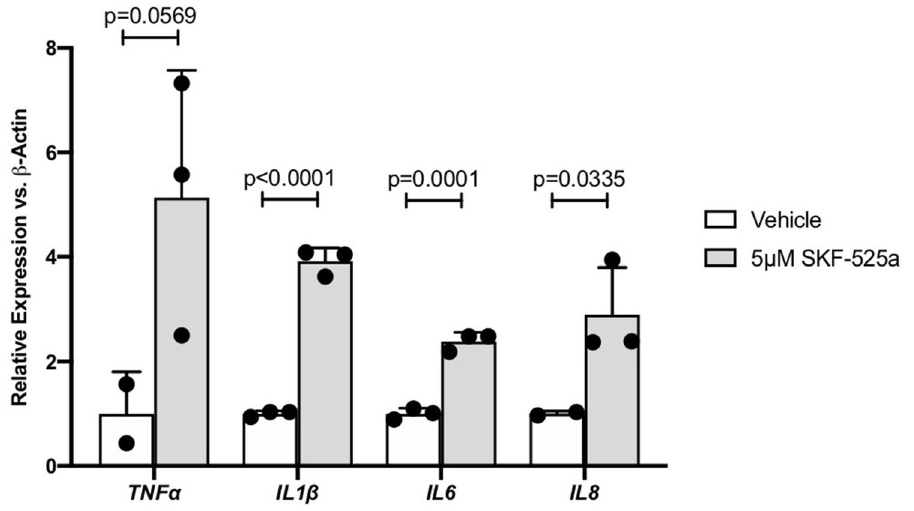
Figure 1. The effect of CYP inhibitor SKF-525a on Müller cell inflammatory cytokine expression. Human Müller cells were treated with SKF-525a (5.0 μM) for 24 h. After treatment, total RNA was isolated and inflammatory cytokine expression was assayed by qRT-PCR. TNFα , IL1β , IL6 and IL8 expression was increased by SKF-525a, though statistical significance was not achieved for TNFα . Data are displayed as mean ± SD (n = 2 or